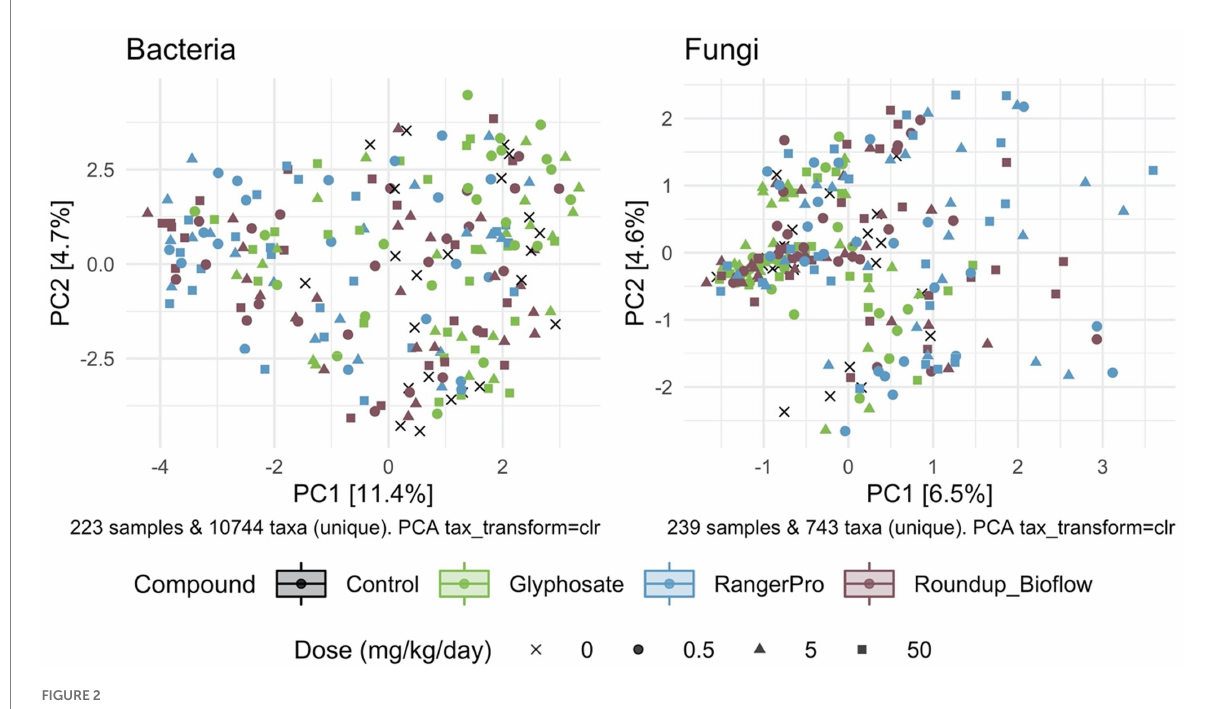
FIGURE 2 Unsupervised classification of variations in bacterial and fungal community composition by PCA. Male and female Sprague Dawley rats were exposed to three doses of glyphosate (0.5, 5, 50 mg/kg body weight per day), or to the formulated products Roundup Bioflow and RangerPro at the same glyphosate-equivalent doses starting at mid-gestation and ending at 13 weeks post-weaning. The PCA was calculated using centred log-ratio transformed abundance data from bacterial 16S rRNA and fungal ITS2 amplicon sequencing of the caecum